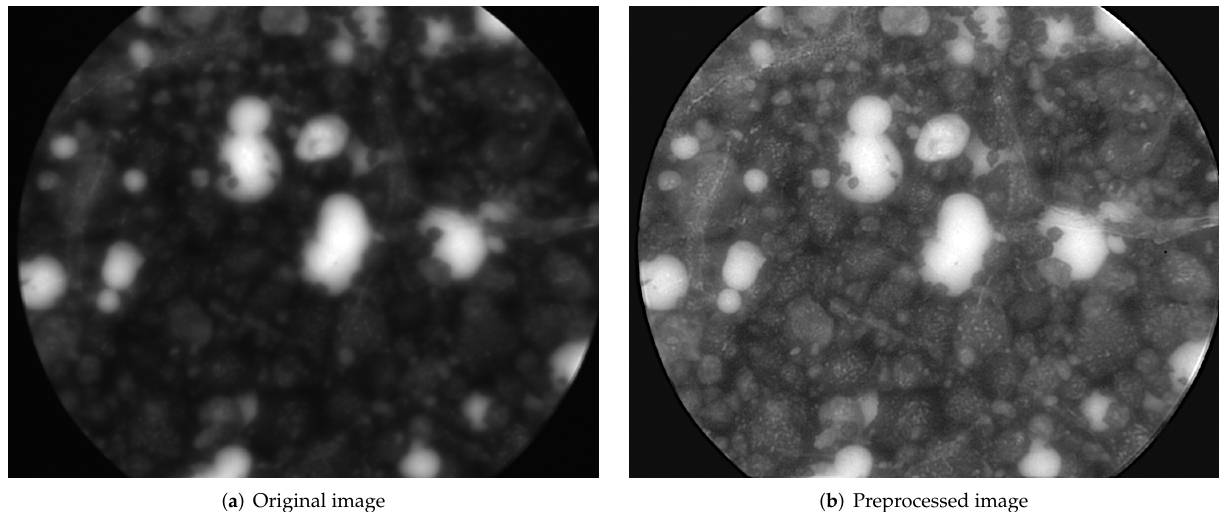
Figure 7. Example of a preprocessed image ( b ) compared to corresponding original image ( a